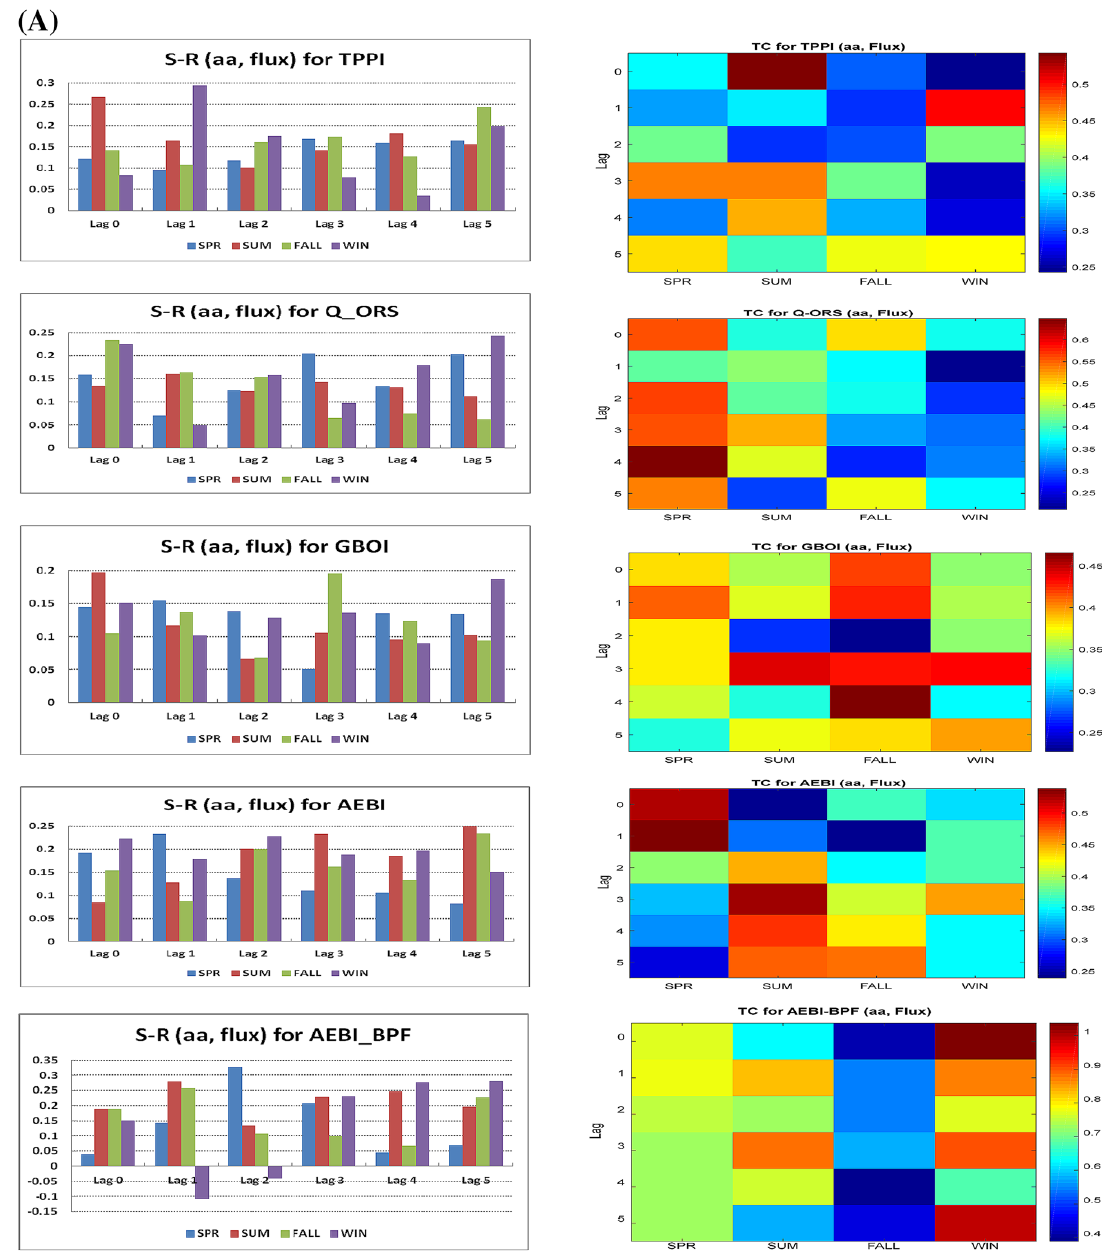
Figure 1. ( A ) The difference between synergy and redundancy (S-R) (left side) and the corresponding total correlations (TC) (right side), for Period I, in case of two predictors taken simultaneously ( aa and solar flux) and climate variables. From top to bottom, TPPI, Q_ORS, GBOI and AEBI. The bottom panels represent (S-R) and TC for BPF data in case of two predictors and AEBI. ( B ) The difference between synergy and redundancy (S-R) (left side) and the corresponding total correlations (TC) (right side), for Period II, in case of two predictors taken simultaneously ( aa and Wolf number) and climate variables. From top to bottom, TPPI, Q_ORS, GBOI and NAOI. The bottom panels represent (S-R) and TC for BPF data in case of two predictors and